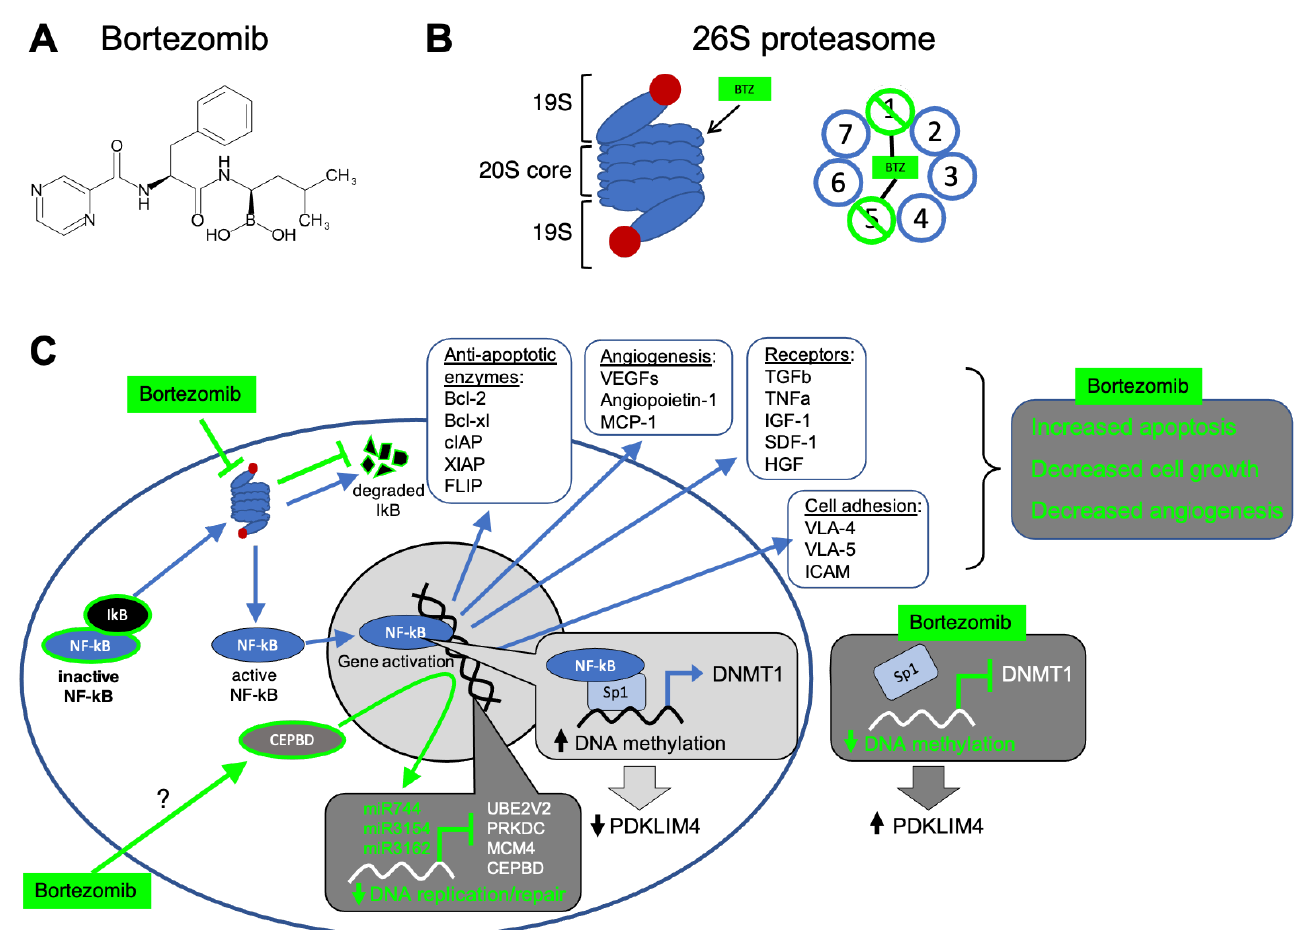
Figure 4. Cellular and epigenetic mechanisms of bortezomib in hematological malignancies. ( A ) Chemical structure of Bortezomib. ( B ) After entering the cell, bortezomib interacts with the 20S catalytic core of the proteasome, rendering the core’s β 1 and β 5 subunits inactive. ( C ) This proteosome inactivation interrupts the NF-kB pathway. In a malignant cell with unhindered proteasomal function, NF-kB’s inhibitory molecule, IkB, is degraded by the proteasome. Thus, in its active form, unbound NF-kB is free to enter the nucleus and activate transcription of genes that support survival and proliferation of malignant cells by upregulating the expression of cell adhesion molecules (i.e., VLA-4, VLA-5, ICAM), angiogenesis promoting factors (i.e., VEGFs, angioprotein-1, MCP1), anti-apoptotic enzymes (i.e., Bcl-2, Bcl-XL, cIAP, XIAP, FLIP), and various signaling molecules/receptors (i.e., IL-6, TGF β , TNF α , IGF-1, SDF-1, HGF). Bortezomib-mediated loss of proteasomal function, keeps NF-kB bound to its inhibitor (IKB) and prevents its nuclear entry. Consequently, the inactive form of NF-kB—unable to enter the nucleus—disables Sp1-mediated transcriptional activation of DNMT1 gene. Under normal conditions, functional interaction between NF-kB and Sp1 activates transcription of DNMT1 gene, resulting in DNA hypermethylation. Bortezomib-mediated inhibition of NF-kB pathway decreases DNMT1 expression leading to hypomethylation of a tumor suppressor gene PDKLIM4 (PDZ and LIM domain 4). Mechanisms underlying bortezomib-mediated regulation of epigenetic pathways and gene targets are under investigation. By mechanisms yet to be determined, bortezomib can potentiate the transcription factor CCAAT/enhancer binding protein delta (CEBPD) leading to the upregulation of miRNAs (miR744, miR3154, miR3162) capable of repressing the expression of the oncogenes UBE2V2 (ubiquitin conjugating enzyme E2 V2), PRKDC (protein kinase DNA-activated catalytic subunit), and MCM4 (minichromosome maintenance complex component 4). Despite remaining mechanistic questions, bortezomib can block cellular pathways to facilitate malignant growth and alter DNA methylation, and thereby a treatment for hematological